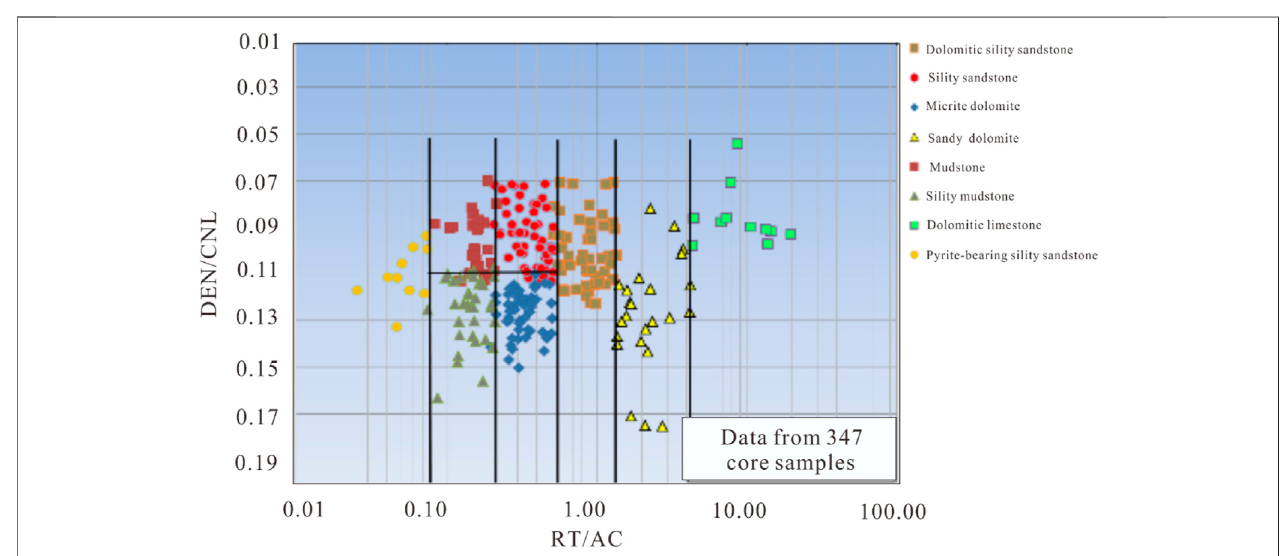
FIGURE 5 | Crossplot of RT/AC and DEN/CNL